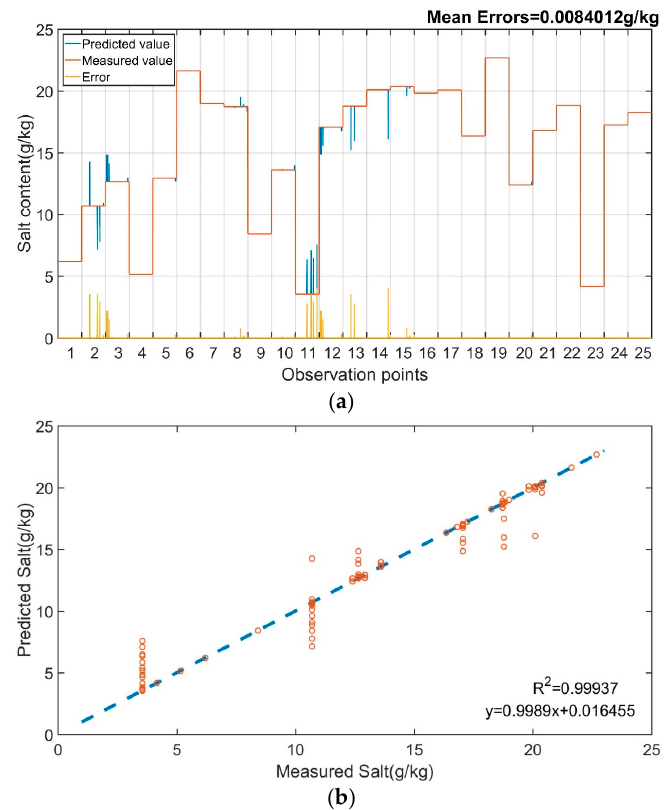
Figure 8. PNN model prediction results in Area A: ( a ) under different observation points; and ( b ) linear fitting.